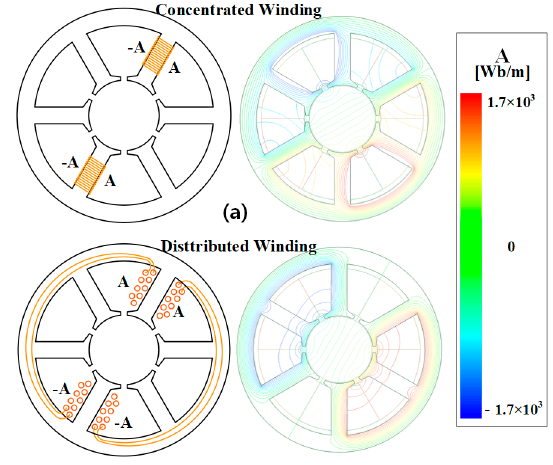
Figure 2. Stator layouts and magnetic flux line distribution according to armature reaction of a 2 pole/6 slot motor ( a ) concentrated, ( b ) distribute winding model. Table 1. High speed motor design specifications according to winding patterns. Characteristic Concentrated Winding Distributed Winding Unit Stack